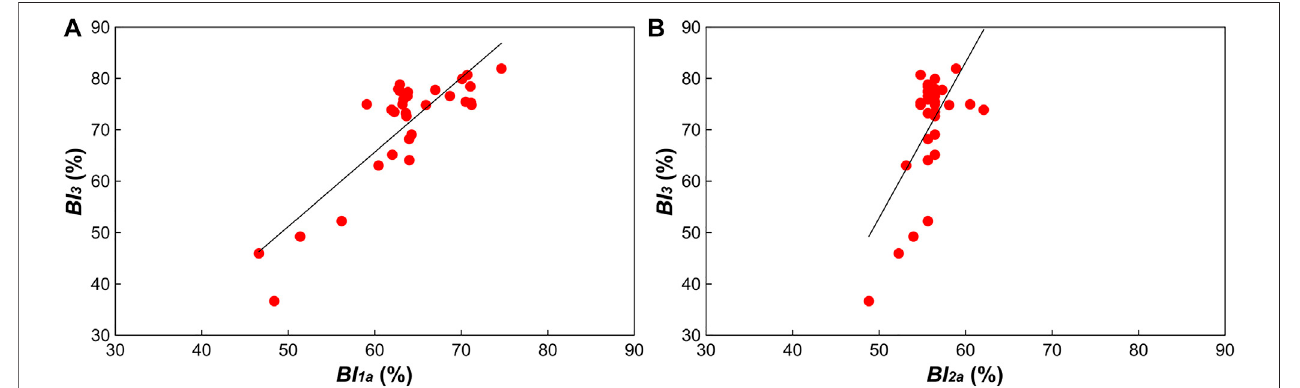
FIGURE 3 | Cross plots of BI 3 versus (A) BI 1a and (B) BI 2a